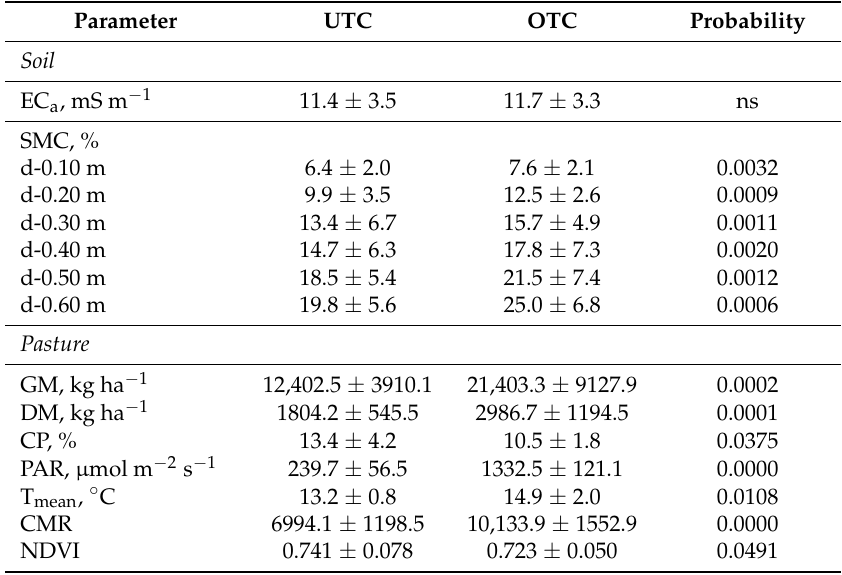
Table 1. Mean and standard deviation of measured parameters in April 2016 and probability of significant differences between under tree canopy (UTC) and outside tree canopy